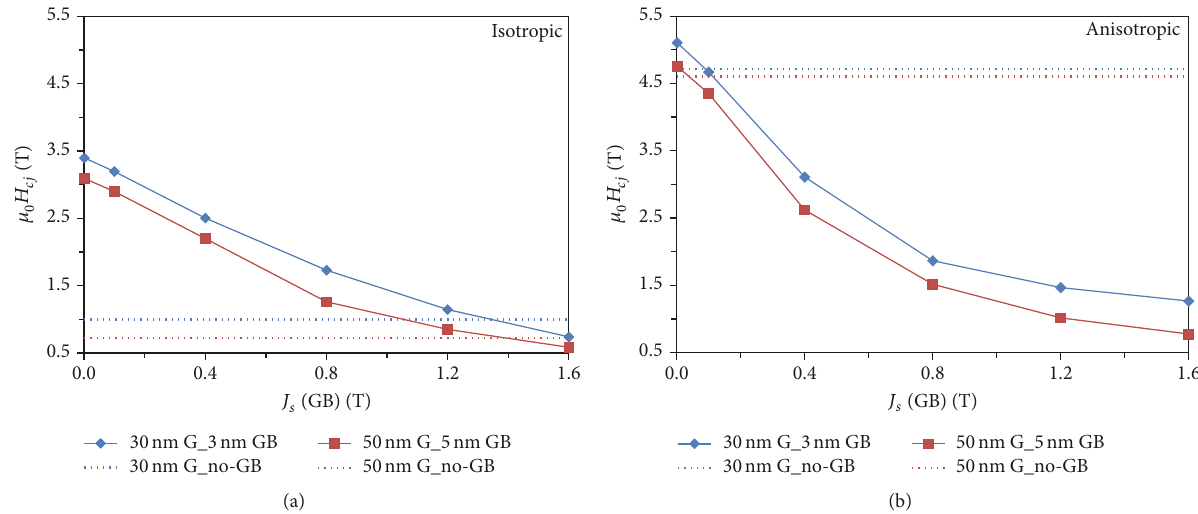
Figure 19: Influence of the averaged magnetic properties, the grain size and GB thickness on the coercive field. (a) Isotropically oriented grains. (b) Isotropically oriented